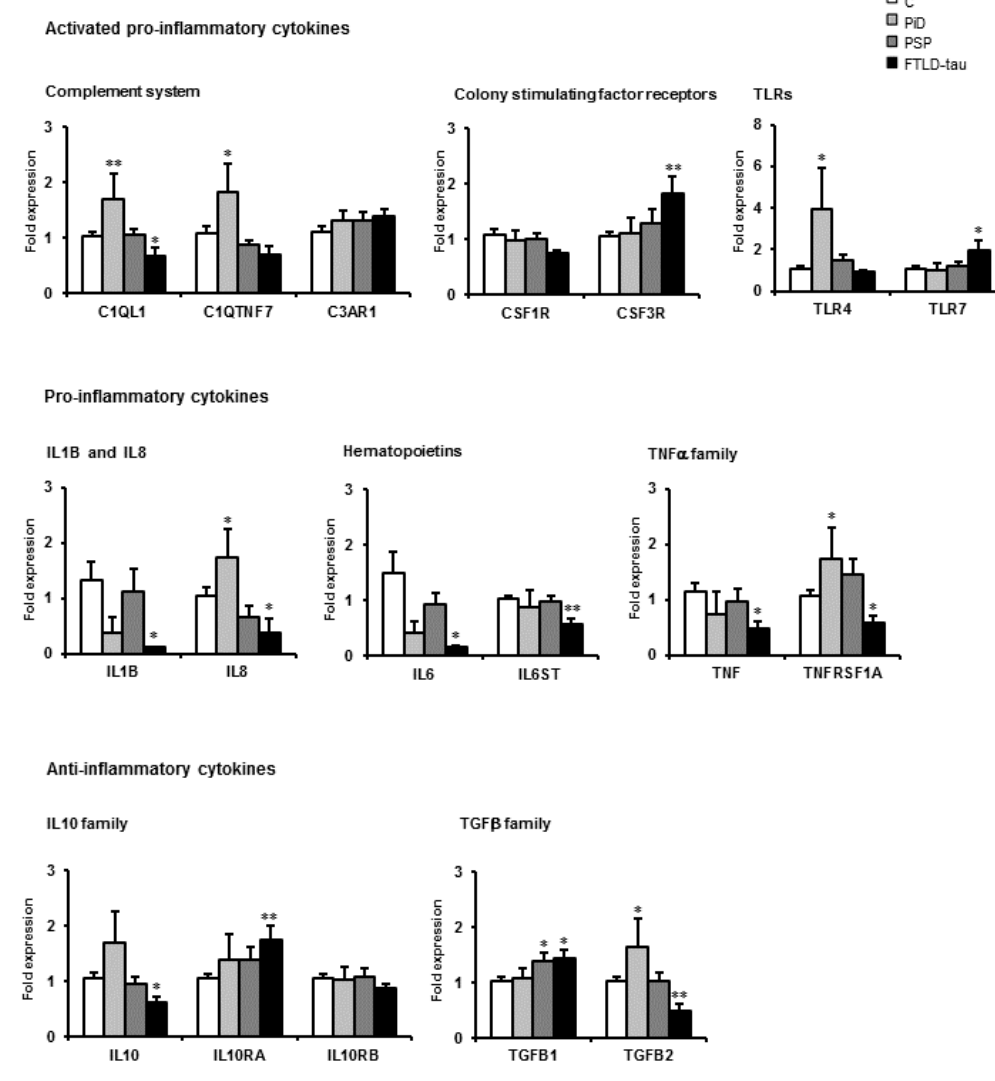
Figure 4. mRNA expression of selected cytokines and mediators of the immune response in the frontal cortex in Pick’s disease (PiD, n = 5), progressive supranuclear palsy (PSP, n = 8), frontotemporal lobar degeneration-tau P301L (FTLD-tau; n = 5), and age-matched controls (C, n = 18). Data are represented as the mean ± SEM * p < 0.05, ** p < 001.